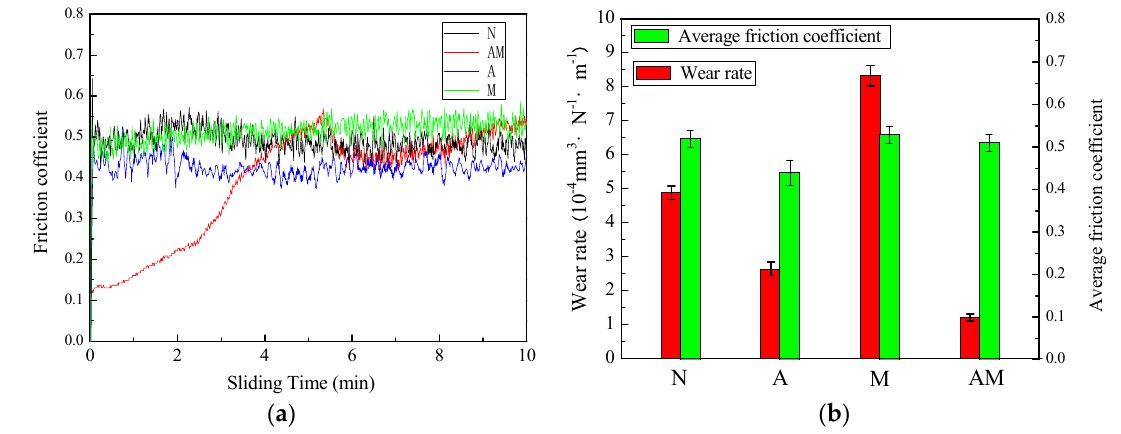
Figure 5. ( a ) The friction coefficient and ( b ) the average friction coefficient and wear rate for all samples tested under a normal load of 2 N and a fixed sliding speed of 47 mm/s.